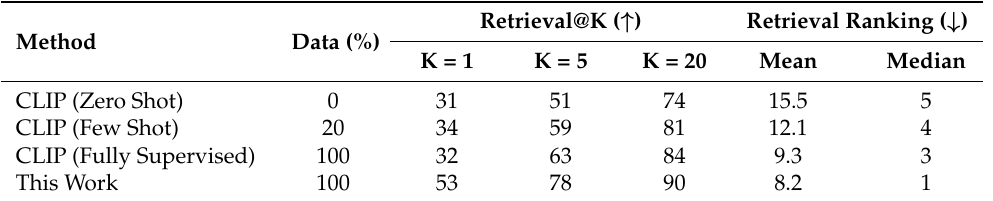
Table 2. Results and Comparison for Image-based Ground-Truth Poem Retrieval out of 100 Poems. ( ↑ : higher is better, ↓ : Lower is